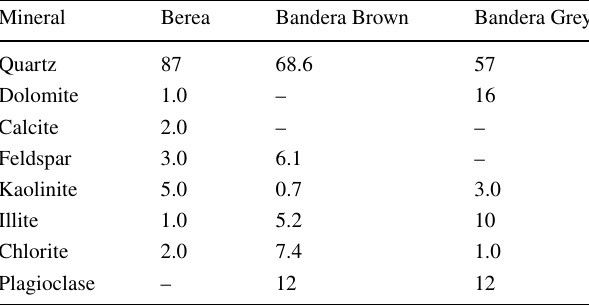
Table 1 Mineralogy of sandstone cores used in this study